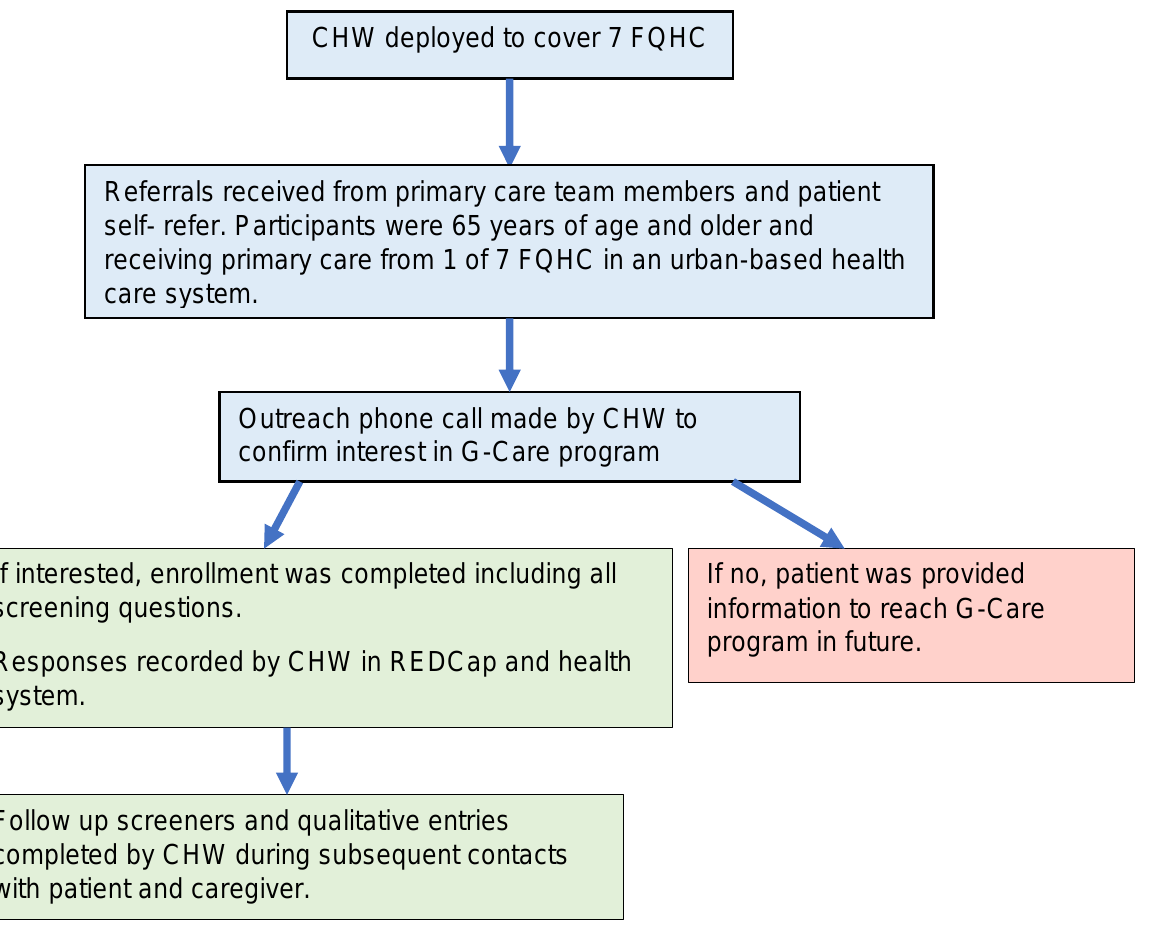
Figure 1. Recruitment and Enrollment Process.